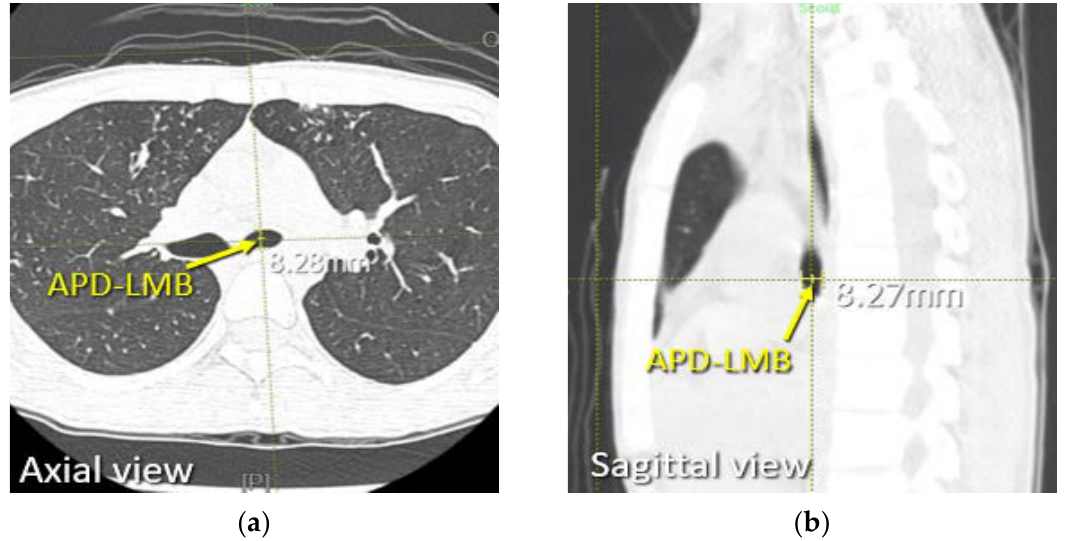
Figure 4. Measuring of the patient’s APD-LMB, performed at 1 cm below carina on chest CT. ( a ) Coronal section of chest CT showing measurement for APD-LMB. ( b ) Sagittal section of chest CT showing measurement for APD-LMB.